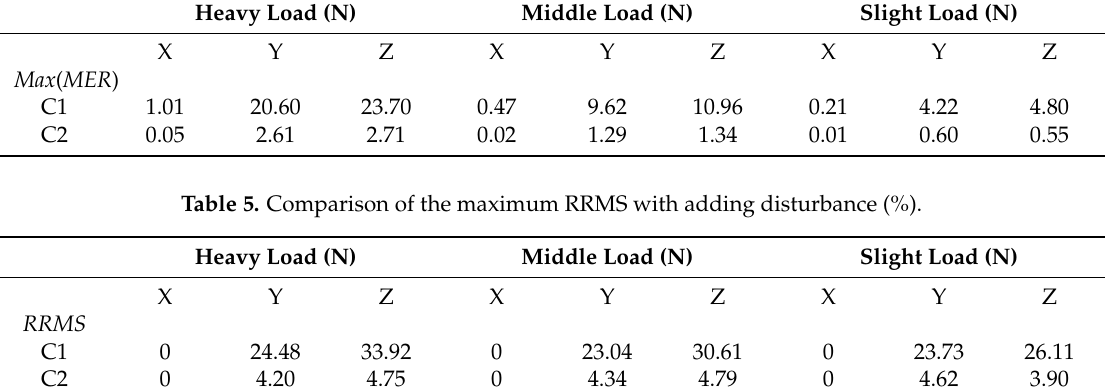
Table 4. Comparison of the maximum deformation errors with adding disturbance (mm). Heavy Load (N) Middle Load (N) Slight Load (N)